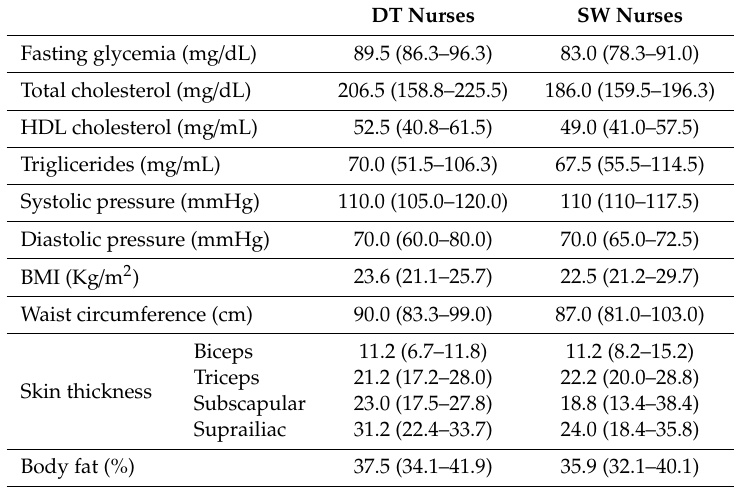
Table 2. Metabolic characteristics of daytime (DT) and shift-working (SW) nurses. Results are expressed as median (25th–75th percentile).